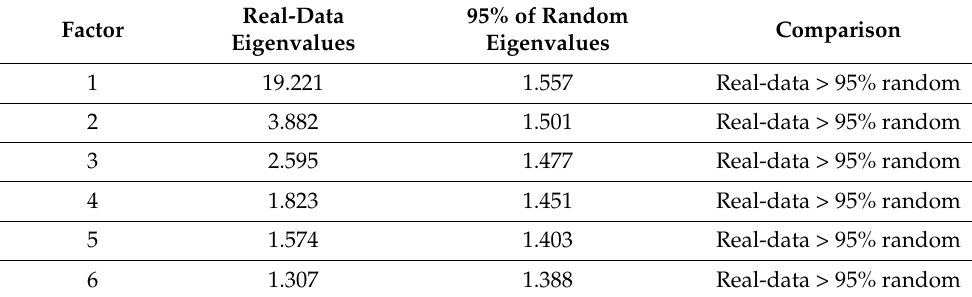
Table 9. Parallel Analysis Results.